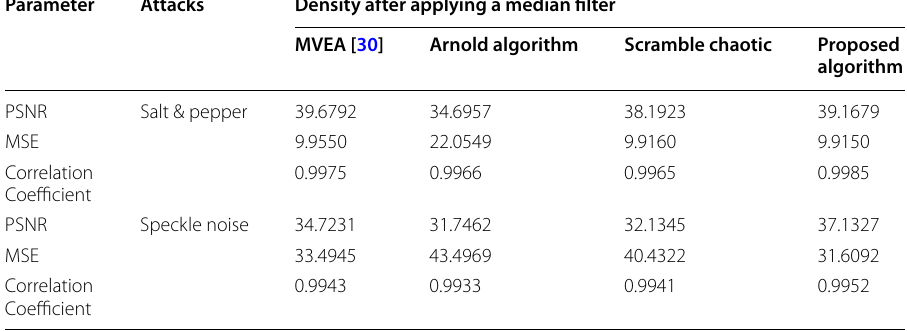
Table 11 Density after applying a median filter Parameter